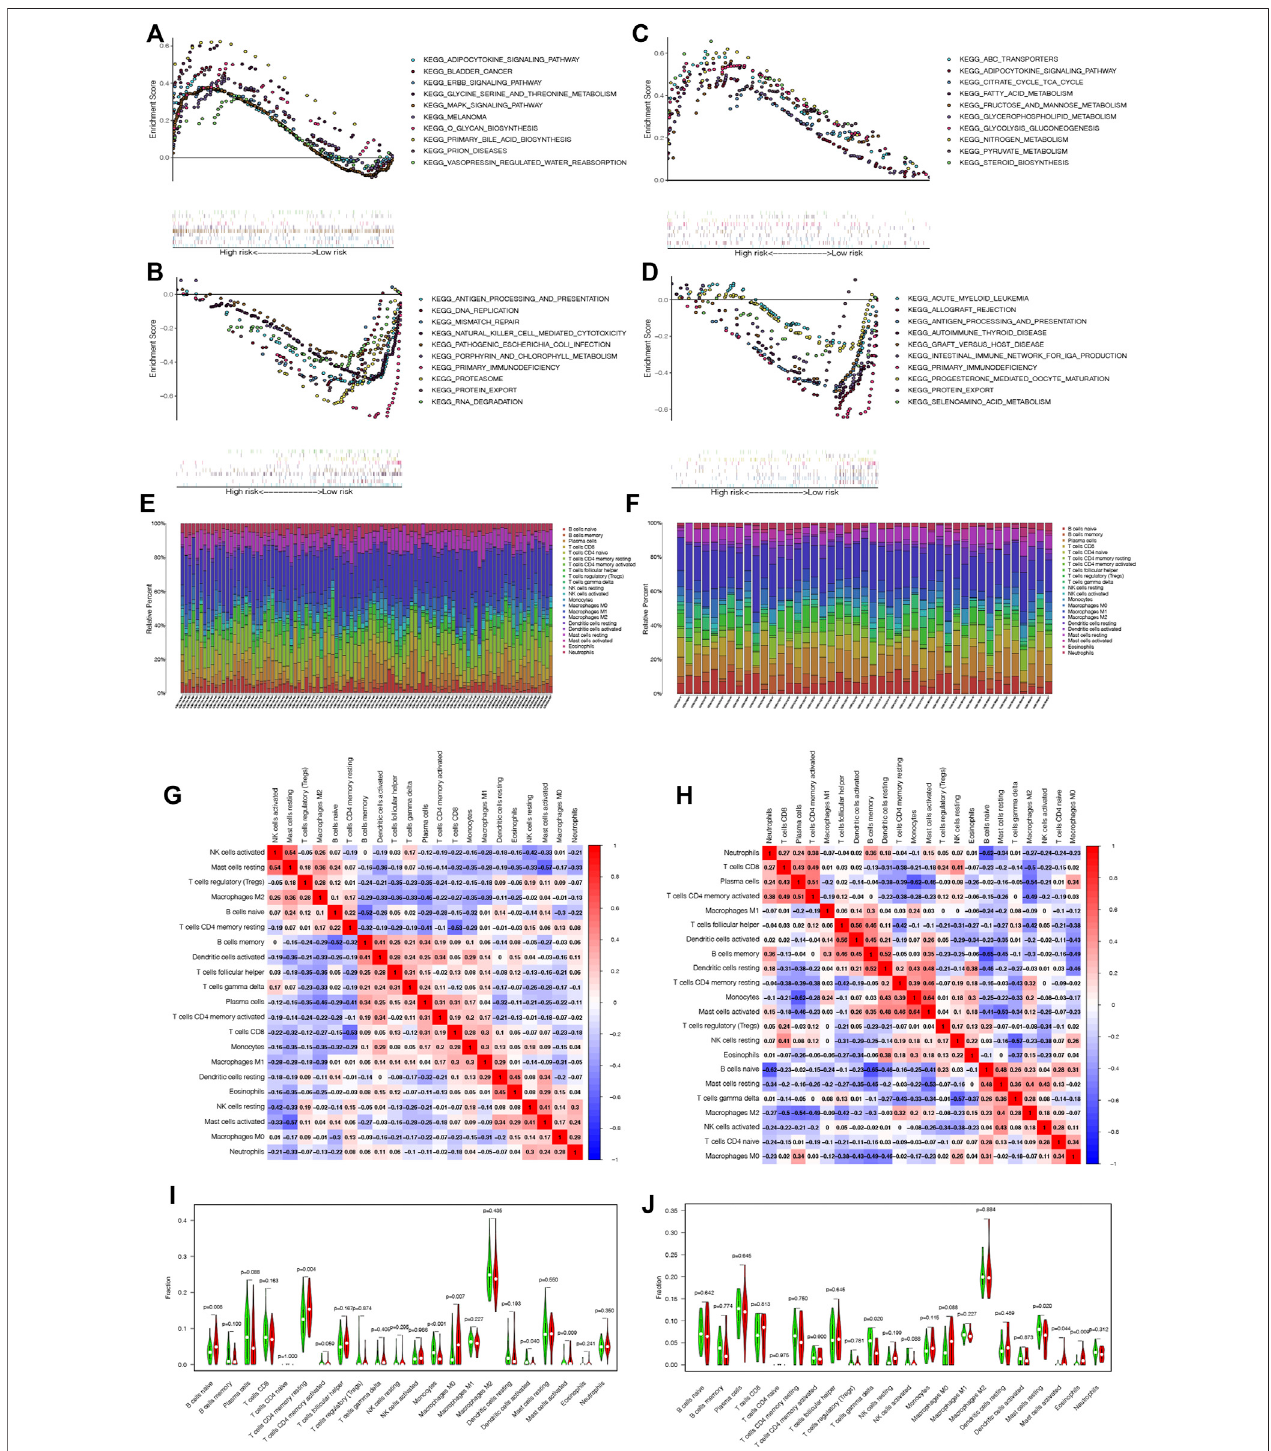
FIGURE 7 | Gene Set Enrichment Analysis shows that pathways enriched in the high ATF3 group were associated with metabolism in the GPL570 and GPL96 databases (A and C) , while the in fl ammation- and immunoregulation-associated pathways were enriched in the low ATF3 group in the GPL570 and GPL96 databases (BandD) . (EandF) Therelativepercentageofdifferentin fi ltratedimmunecellsinrheumatoidarthritis(RA)samplesintheGPL570andGPL96databases. (GandH) The immune cell correlation matrix was constructed to explore the correlation among all in fi ltrated immune cells in the GPL570 and GPL96 databases. (I and J) The in fi ltratedimmunecellsbetweenthehighandlowATF3groupswerecomparedintheGPL570andGPL96databases,andthecontentsofactivatedmastcellsinthehigh ATF3 group were widely and signi fi cantly higher than those in the low ATF3 group in both databases. * p < 0.05.